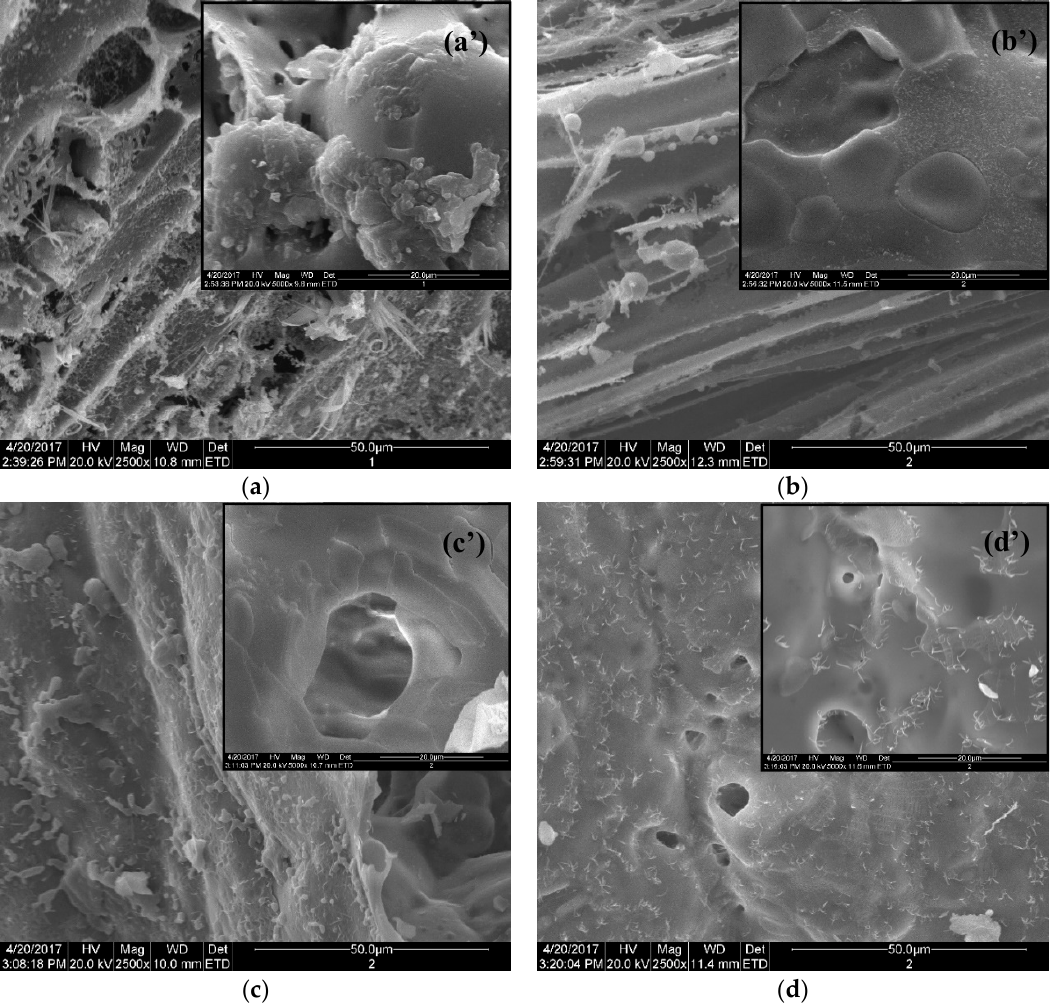
Figure 4. SEM images of specimens after combustion including ( a ) S0, ( b ) S1, ( c ) S2, and ( d ) S5 with 2500×, and the same images (5000×) contain ( a’ ) S0, ( b’ ) S1, ( c’ ) S2, and ( d’ ) S5.